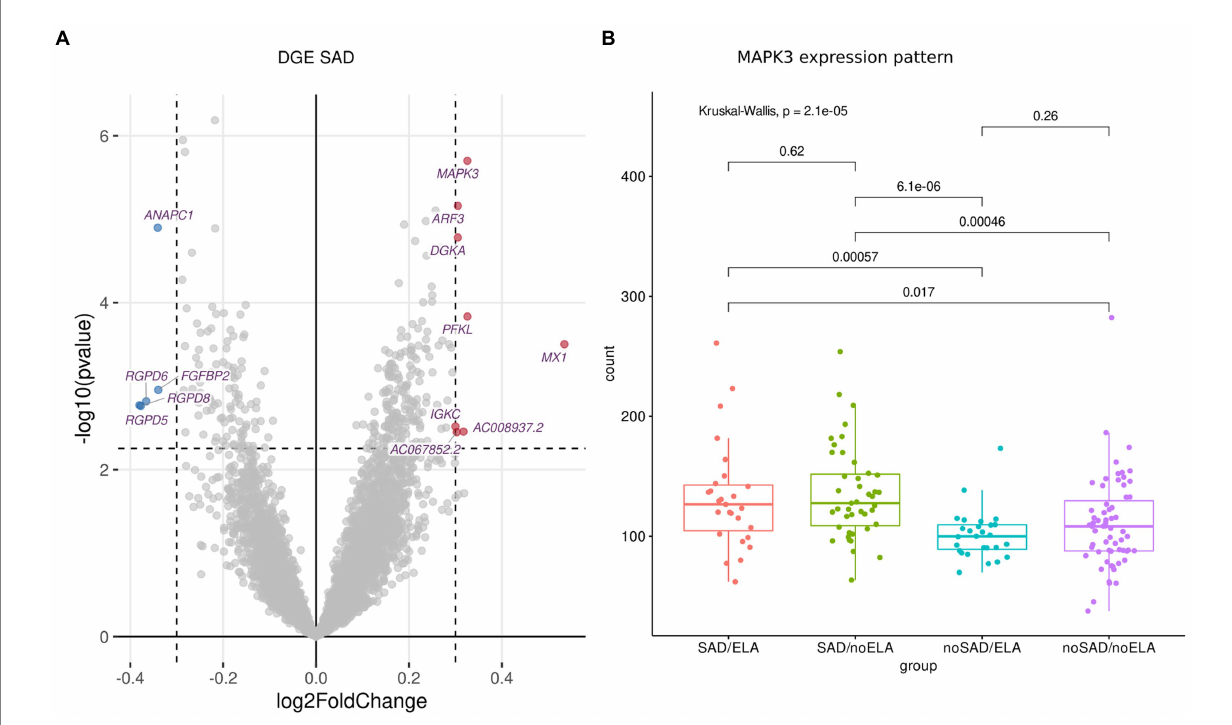
FIGURE 1 DGE analysis between SAD and control group using normalized gene counts adjusted to cell type ratio. (A) Volcano plot displaying the significantly (FDR-corrected p ≥ 0.1) differentially (|l2fc| ≥ 0.3) expressed genes with downregulated genes marked in blue and upregulated genes marked in red. (B) The expression patterns of the most significantly differentially expressed gene MAPK3 displayed in gene counts with respect to SAD and ELA show increased gene counts in the SAD groups without an influence of ELA. Wilcoxon rank sum test was applied and p values were adjusted for multiple testing using Benjamini–Hochberg correction. Kruskal-Wallis-Test additionally shows significantly different MAPK3 expression between the SAD/ no SAD (with respect to ELA)